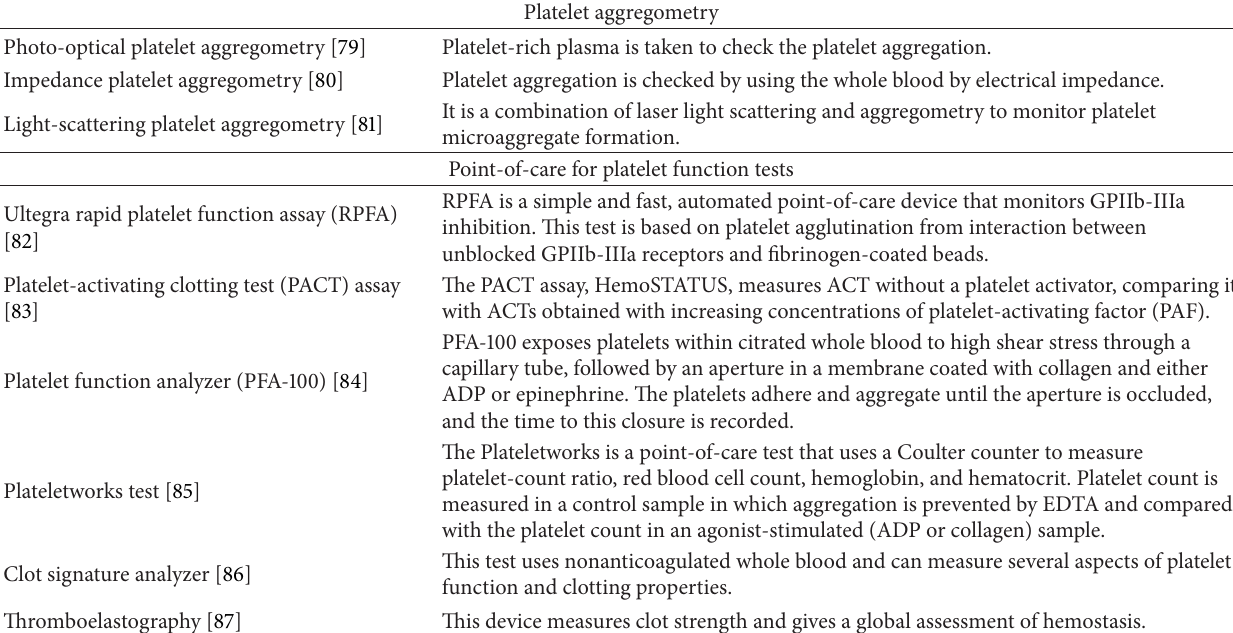
Table 3: Clinical assessment of platelet